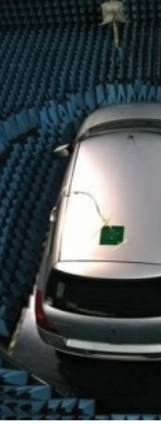
Figure 27. Proposed antenna mounted on vehicle’s rooftop [104].